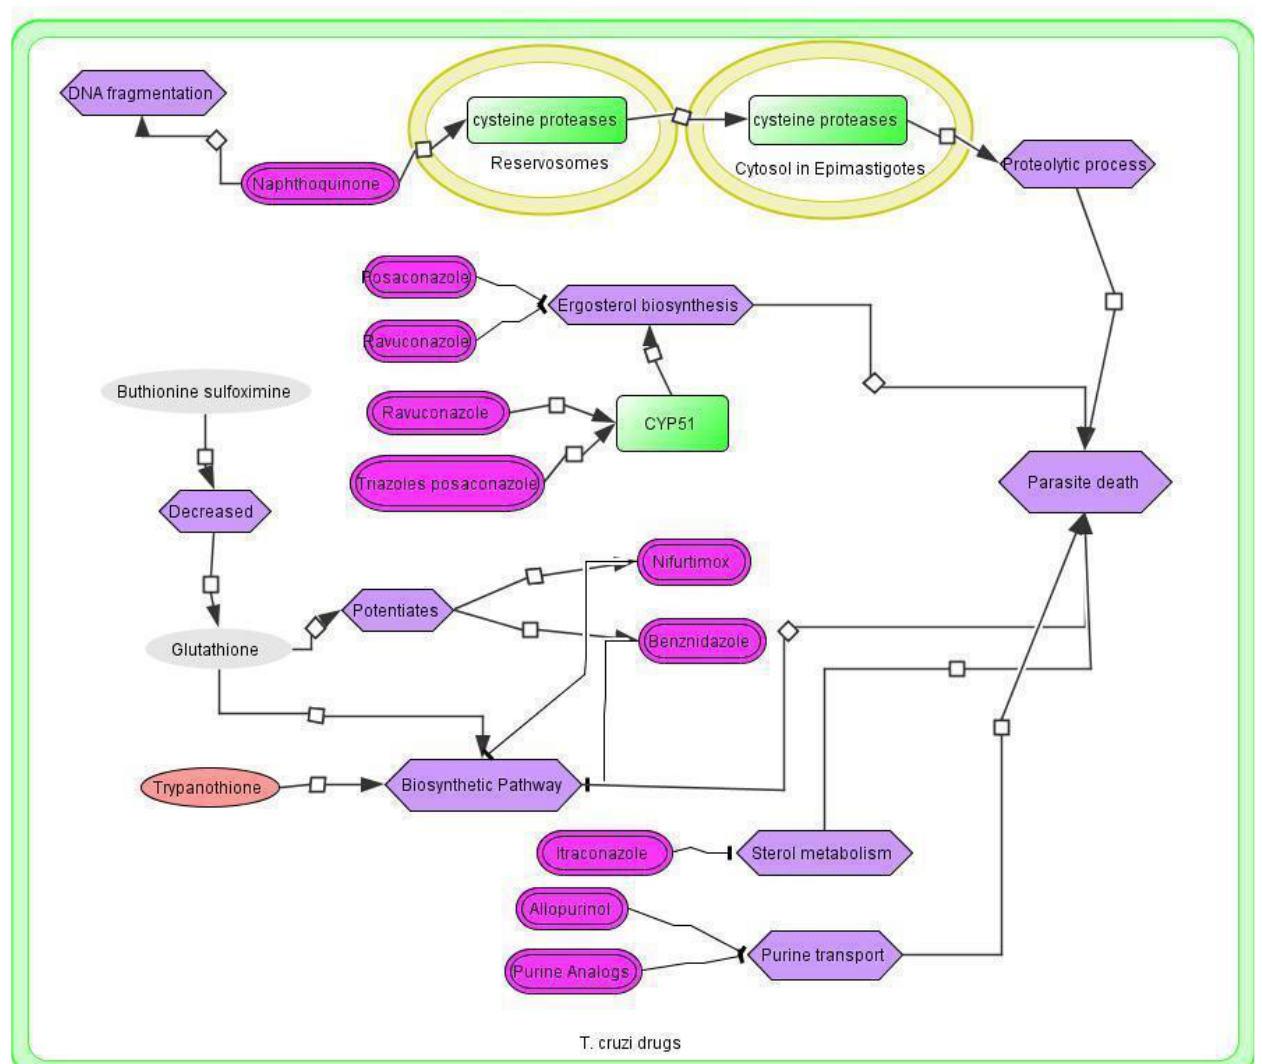
Figure 4. The drug network of T. cruzi developed using CellDesigner